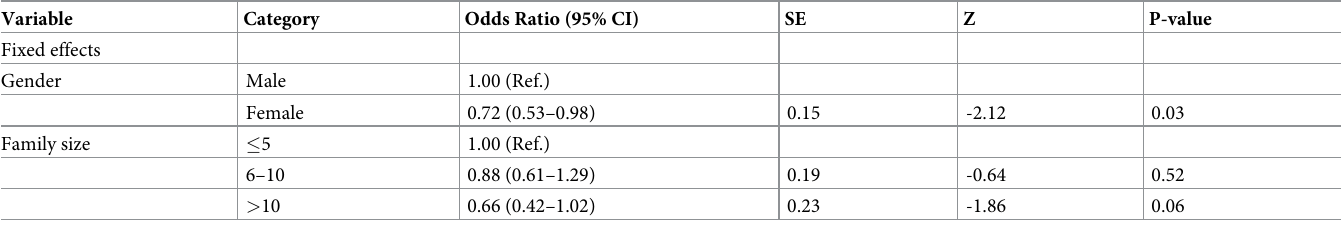
Ref., reference category; CI, confidence intervals; SE, standard error Log likelihood = -535.90, number of observations = 970, number of households = 339 The variance for the random effect variable (household ID) was 0.093 (95% CI: 0.00–0.71), SE = 0.18